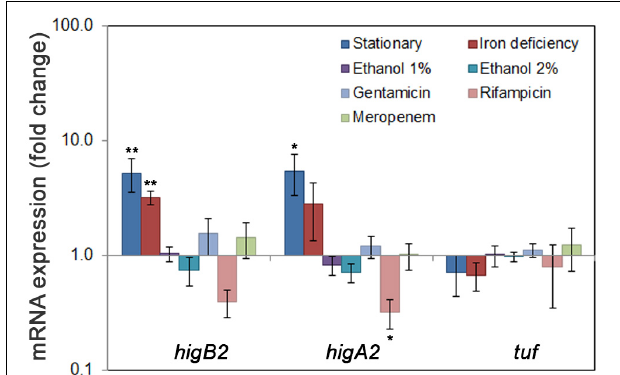
FIGURE 5 | Expression of A. baumannii higBA2 Ab locus during stress conditions. A. baumannii clinical strain K60 was grown in LB to exponential phase (OD 600 = 1) and to stationary phase (blue bars); in conditions mimicking iron deficiency (LB with or without 2,2 (cid:48) -bipyridine) (red bars), in LB with 1 or 2% ethanol added (purple and cyan bars, respectively) and LB with antibiotics (gentamicin, rifampicin, meropenem, in light blue, light red, and light green, respectively) added. The bacteria were collected at OD 600 = 1, except for stationary phase, where the bacteria were grown for 48 h reaching OD 600 of 4.5. Total RNA was isolated and RT-qPCR performed to detect the expression of TA genes as described in Section “Materials and Methods”. The differences in transcript amounts were evaluated by comparative Ct method ( (cid:49)(cid:49) Ct) using rpoB as a house-keeping gene. At least three biological replicas were performed, error bars indicate standard deviation. Statistically significant difference from tuf expression, used as a control, is indicated by one asterisk ( t -test, p < 0.05), or two asterisks ( t -test, p < 0.005).